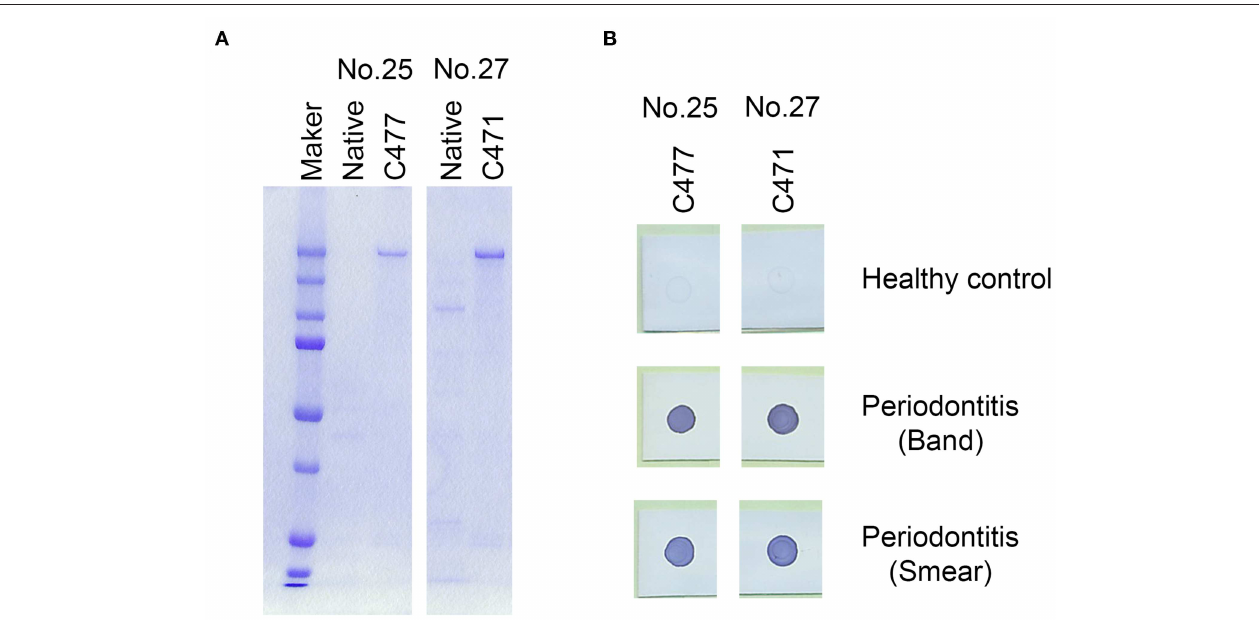
FIGURE 3 | Modification of the cysteine proteases, Lys-gingipain (Kgp; antigen no. 25) and Arg-gingipain (RgpA; antigen no. 27) to inhibit their proteinase activities. Cysteine residues were substituted with alanine residues on C477 of recombinant Kgp and C471 on recombinant RgpA. (A) SDS-PAGE analysis of the mutant recombinant proteins. Approximately, 50 ng of each recombinant protein was loaded into each lane. (B) Serum IgG responses to the mutants as determined by the dot blot analysis. Approximately, 50 ng of each protein was blotted on the membrane, and sera were used at a dilution of